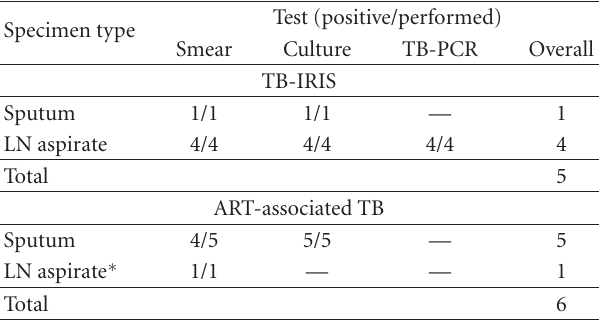
Table 8: Description of TB in patients with TB-IRIS (at the time of IRIS) and ART-associated TB.